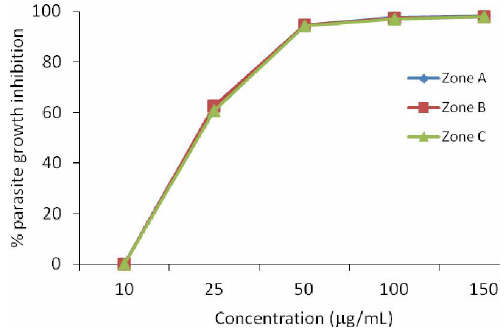
Figure 4. Graph between the concentration of 8-hydroxyisocapnolactone-2  3  -diol versus % inhibition of the growth of chloroquine-sensitive P. falciparum (D-10) on the three measurement zones (A=0-3 keV; B=0-5 keV; C=0.5-8